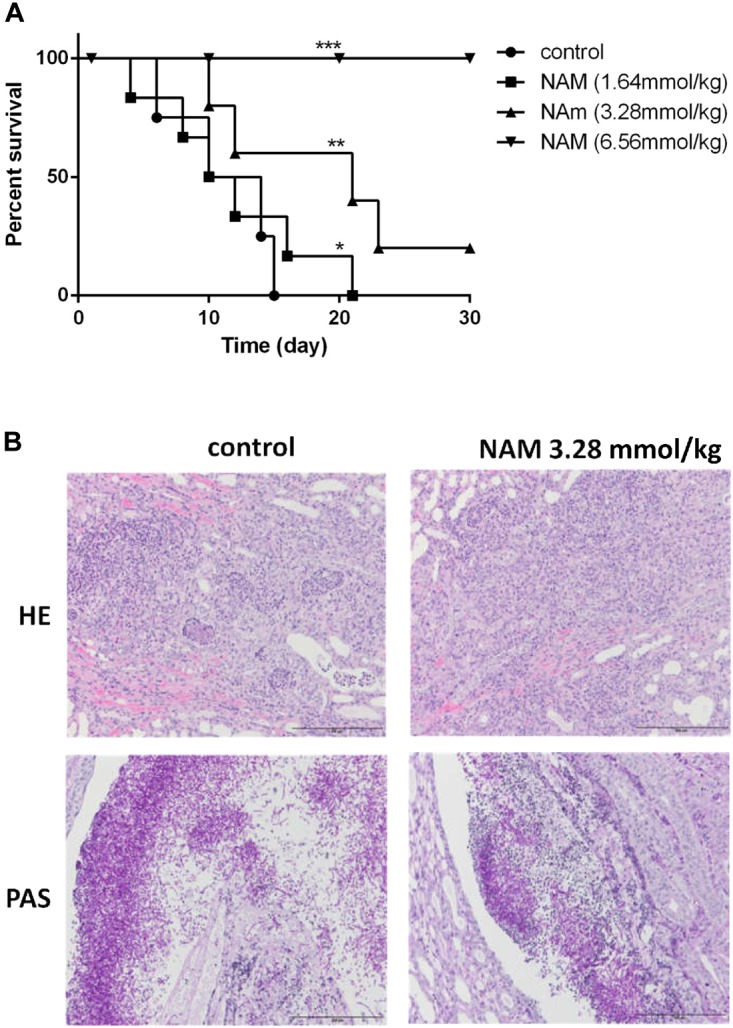
(A) Survival curves of BALB/c mice with disseminated candidiasis treated by NAM. The mice were infected with 5 × 106 CFU C. albicans SC5314 in 200 μl sterile saline intravenously and monitored for 30 days (n = 8 per group). (B) Inflammatory responses and C. albicans colonization in mouse kidney (×200 magnification). Representative HE (hematoxylin and eosin) and PAS (periodic acid-Schiff) staining of kidneys from BALB/c mice infected with 5 × 106 CFU C. albicans SC5314 at day 6 were used to detect the inflammatory cells influx and the extent of tissue necrosis or hyphae invasion. ∗P < 0.05; ∗∗P < 0.01, ∗∗∗P < 0.0005 as compared to the control group.